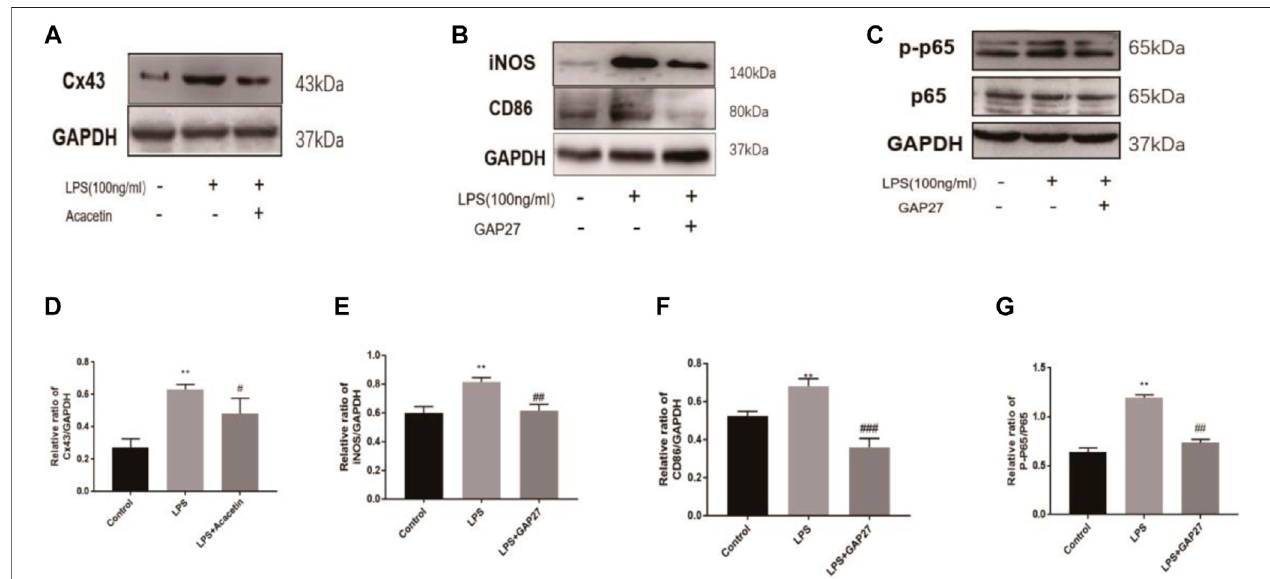
FIGURE 5 | Experimental validation of the acacetin binding signalling pathway predicted by network pharmacology. The expression levels of Cx43, CD86, iNOS, P65 and phosphorylated P65 (A – G) were assessed via Western blotting. The data are expressed as the mean ± SEM ( n (cid:1) 3). * p < 0.05, ** p < 0.01, and *** p < 0.001 compared with the control group; # p < 0.05, ## p < 0.01, ### p < 0.001 compared with the LPS-stimulated group.